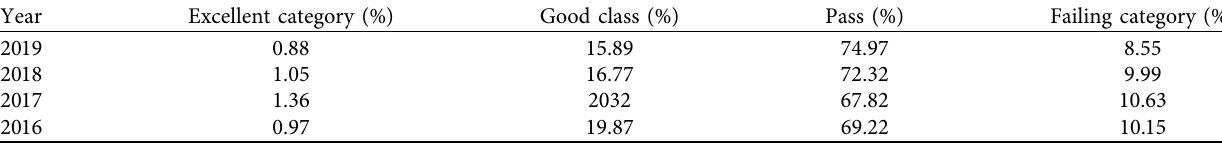
Table 1: The proportion of students at each category from 2016 to 2019.